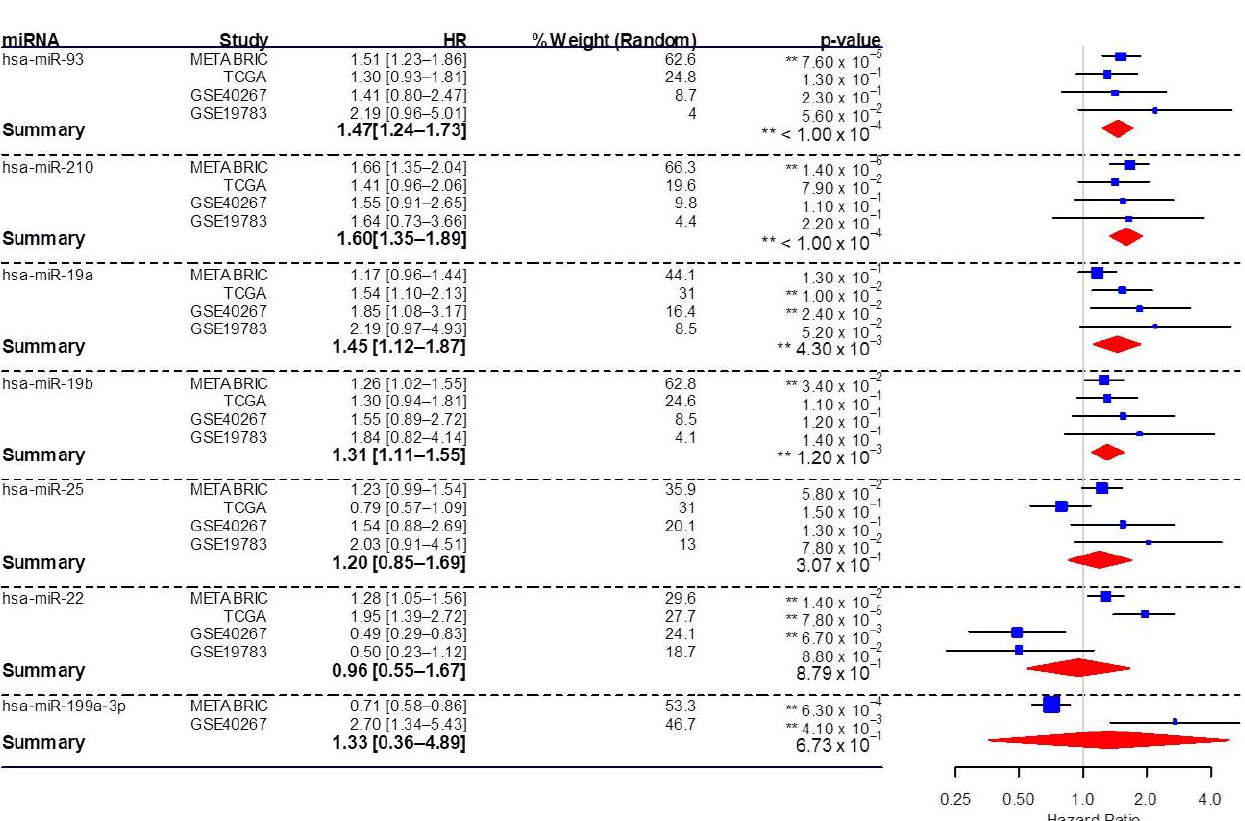
Figure 4. Forest plot showing the association of significant miRNAs in our study with overall survival from various breast cancer studies, including METABRIC, TCGA, GSE40267, and GSE19783. Hazard ratios (HR) and confidence intervals are presented. The relative weight of each study and pooled HR estimates were calculated using the random-effects model. Blue squares represent hazard ratios of individual miRNAs in different breast cancer studies (METABRIC, TCGA, GSE40267, and GSE19783). Red diamonds indicate pooled effect estimates of miRNAs using the random-effects model and a 95% confidence interval. A hazard ratio (HR) >1 indicates that as the miRNA presence in breast cancer increases, risk increases, and thus survival decreases, whereas a risk ratio <1 indicates a reduced risk and increased survival. HR, hazard ratio; TCGA, The Cancer Genome Atlas; METABRIC, Molecular Taxonomy of Breast Cancer International Consortium; miRNA, microRNA. **— p -value <